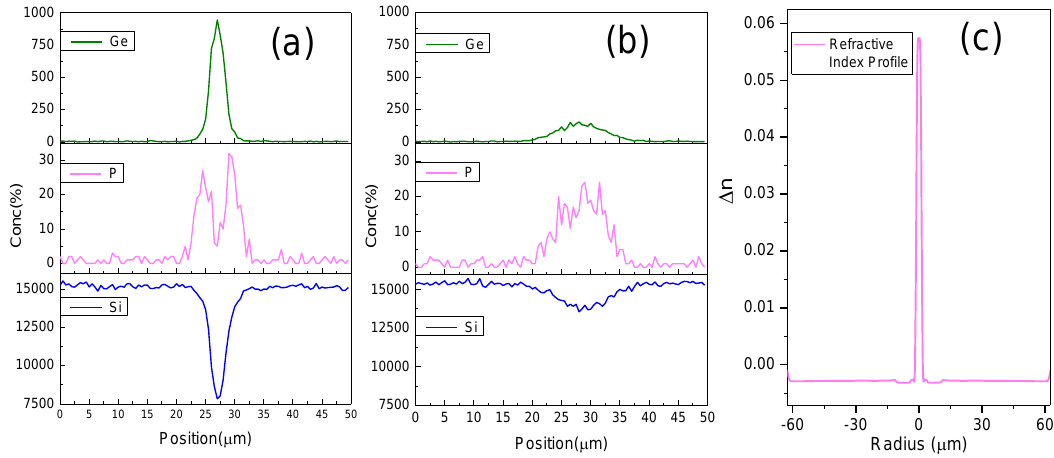
Figure 7. Element distribution on the cross-section of the ( a ) unheated and ( b ) heated UHNA-7 fiber. ( c ) The refractive index profile of the unheated UHNA-7 fiber.